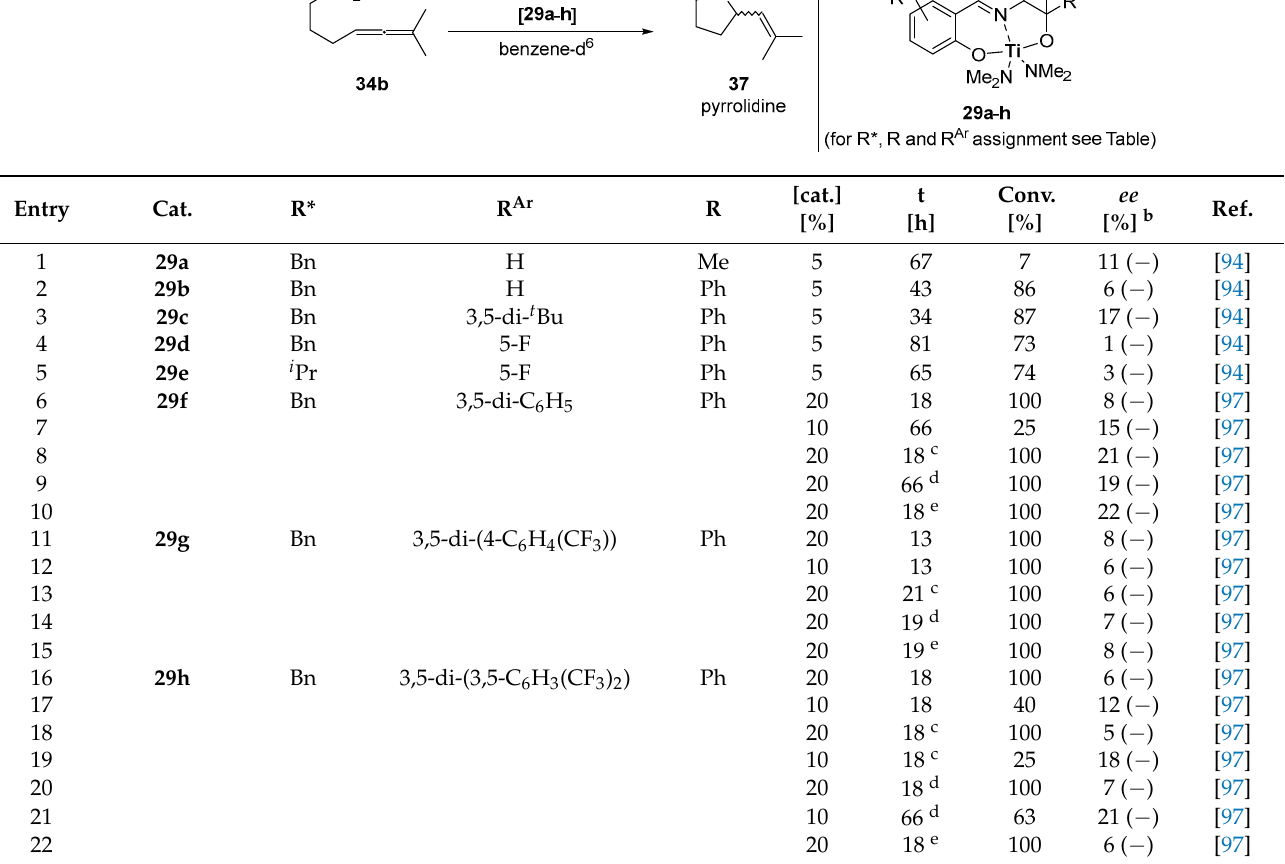
Table 9. Catalytic asymmetric hydroamination of 34b using chiral catalysts 29a – h a .